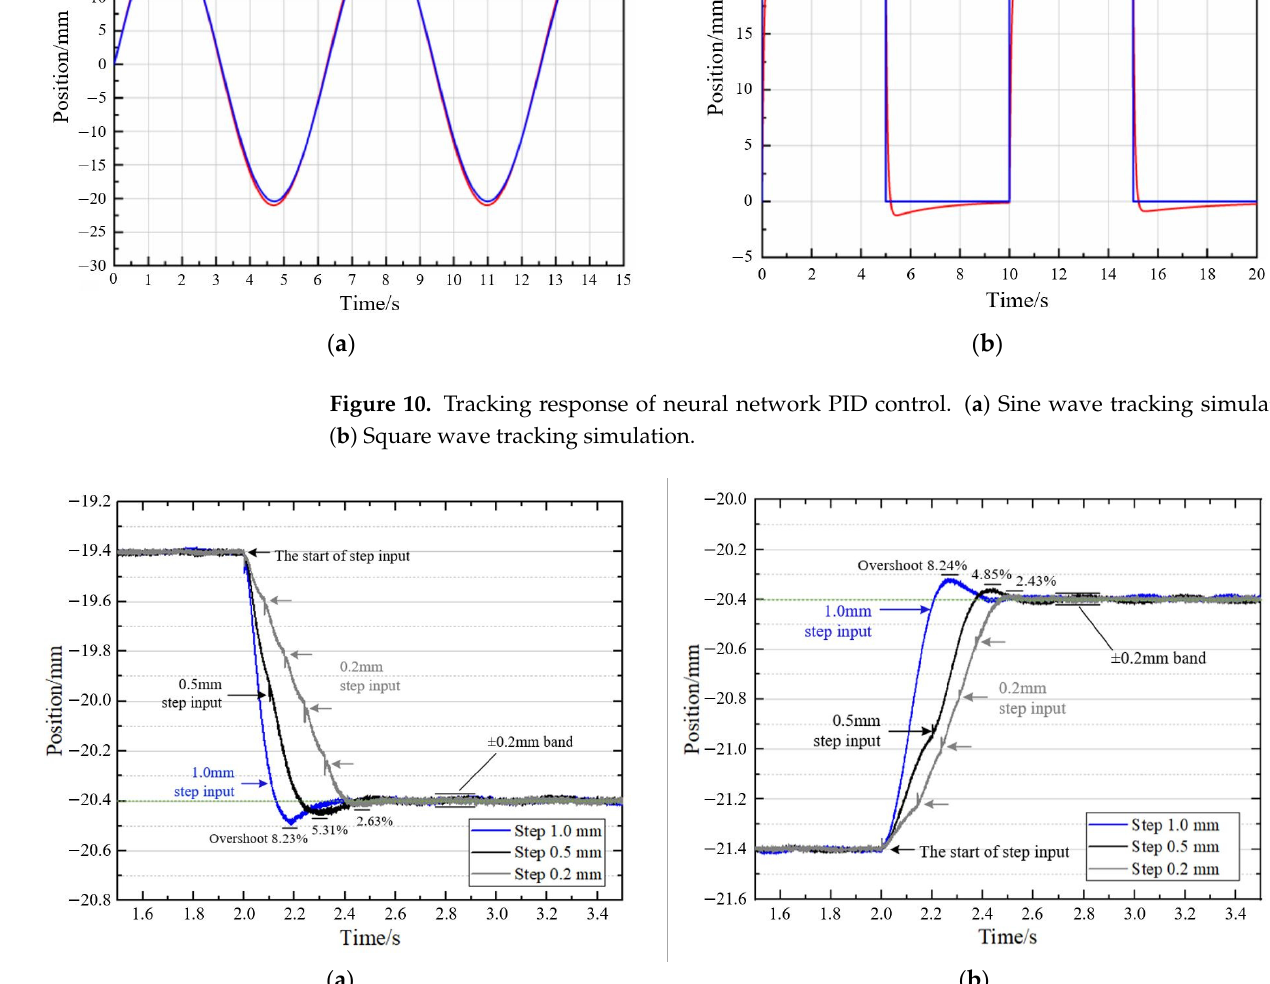
Figure 10. Tracking response of neural network PID control. ( a ) Sine wave tracking simulation; ( b ) Square wave tracking simulation.